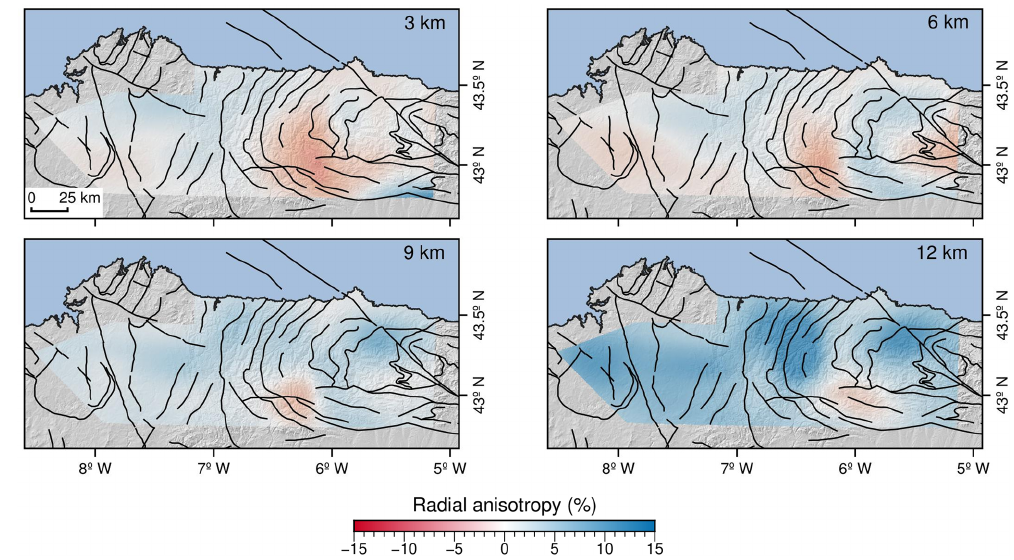
Figure 7. Radial anisotropy maps for depths of 3, 6, 9, and 12km. Black lines represent the main Alpine and Variscan faults.